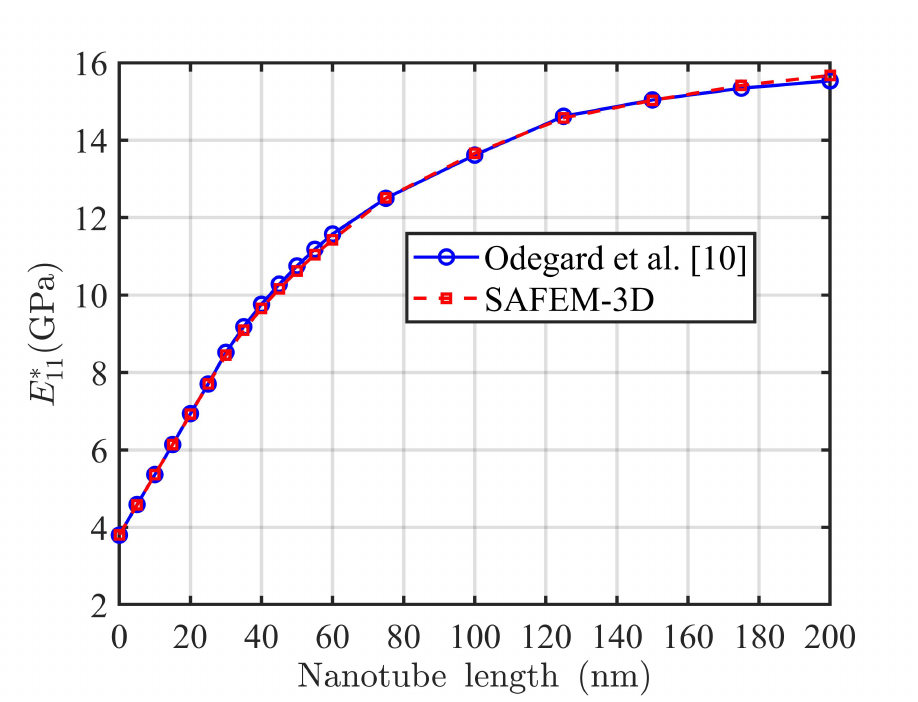
Figure 6. Effective longitudinal Young’s modulus for a two-phase FRC with an aligned isotropic SWNT nanotube [12] with a 1% volume